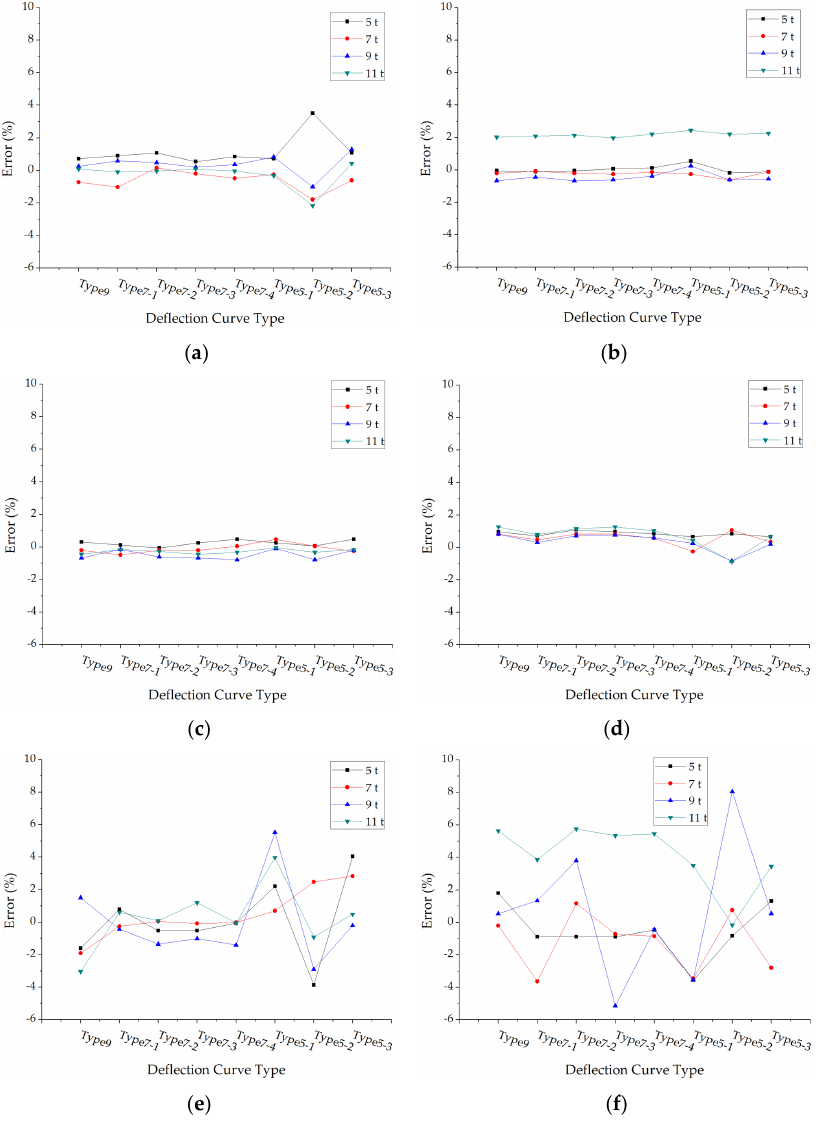
Figure 5. The errors of back calculated surface modulus under different deflection curve types: ( a ) Structure 1; ( b ) Structure 2; ( c ) Structure 3; ( d ) Structure 4; ( e ) Structure 5; ( f ) Structure 6.